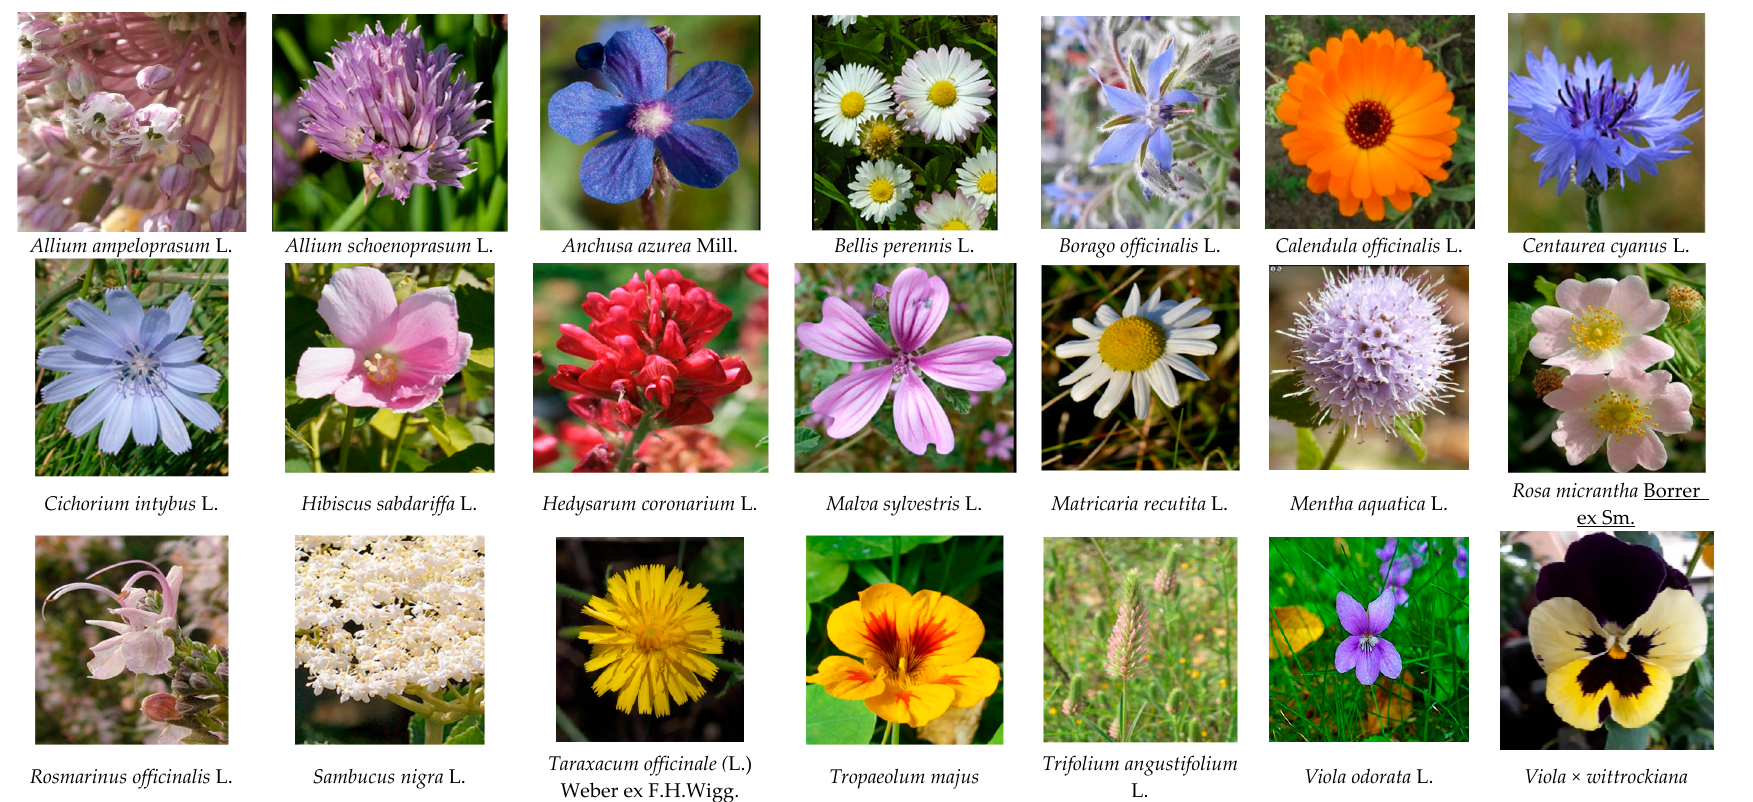
Figure 1. Examples of edible flowers. Sources: Flora-On: Flora de Portugal Interactiva. (2014). Sociedade Portuguesa de Bot â nica